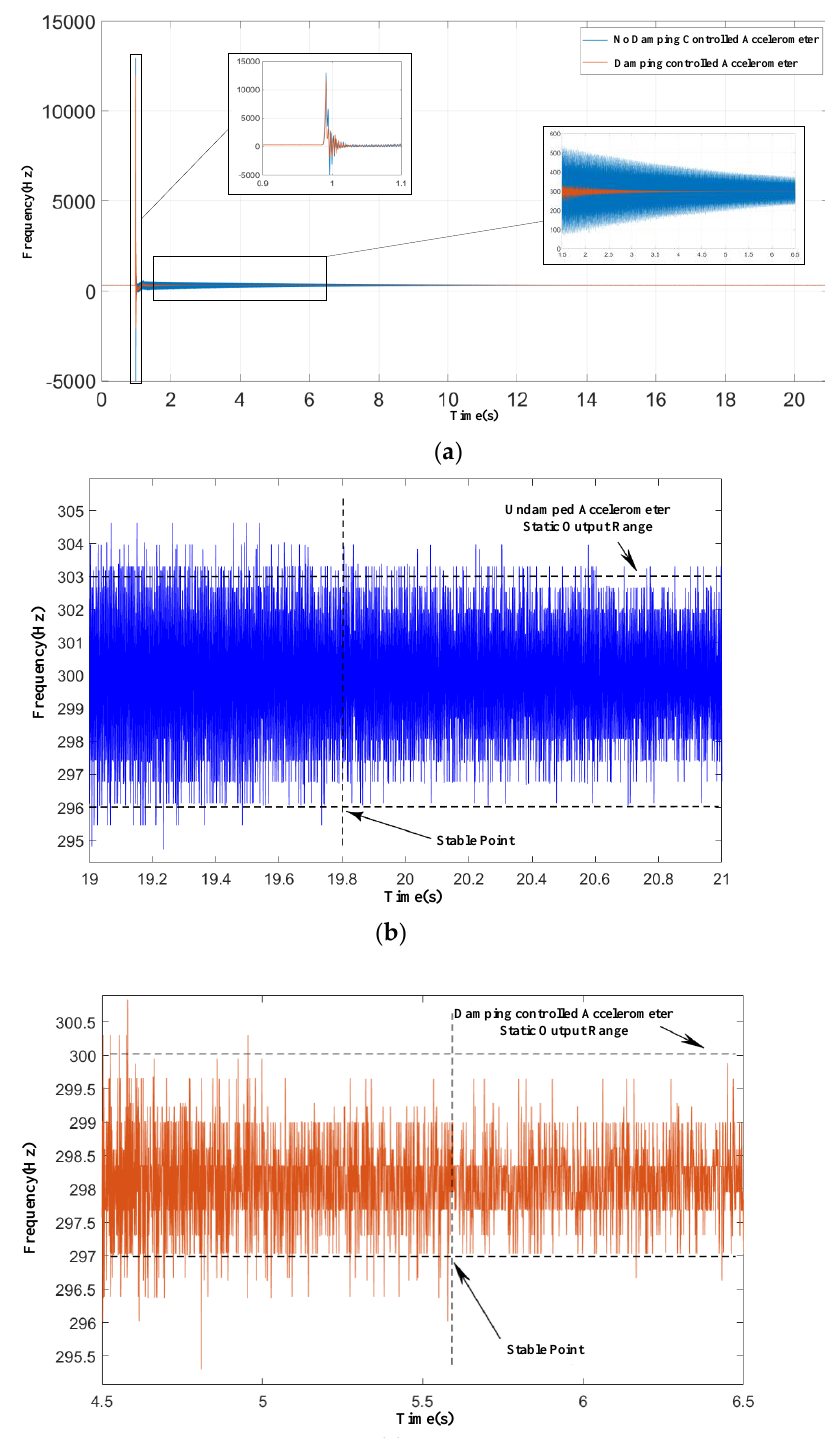
Figure 14. Experimental results: ( a ) Shock response results; ( b ) stabilization time with no damping control accelerometer; and ( c ) stabilization time with damping control accelerometer. Table 3. Experimental data of half-sine shock